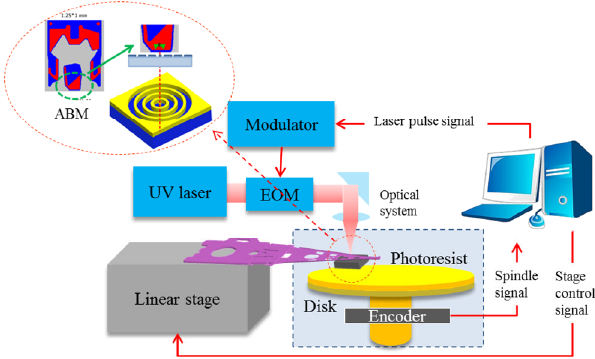
Fig. 1 Rotary near-field lithography (RNFL) system